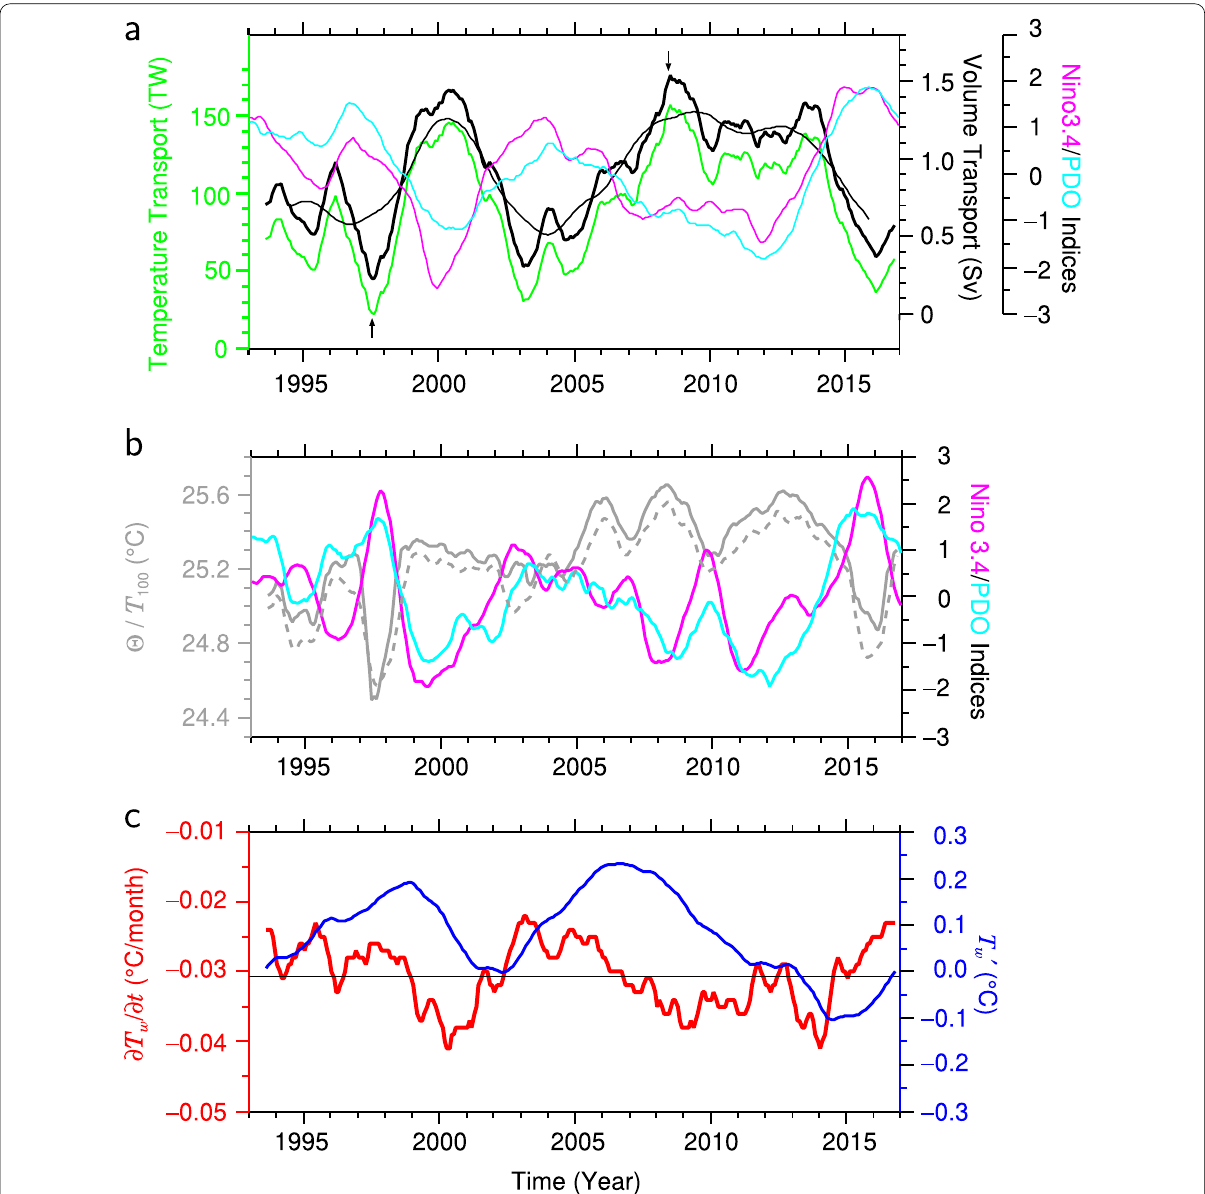
Fig. 14 a Volume transport V z (Sv, thick black line) and temperature transport F z (TW, green line) at 100 m depth in Region A shown by the solid square in Figs. 6, 7, 10, and 11. V z , Niño 3.4, and PDO indices smoothed by a 37-month running mean filter are shown by thin black, magenta, and cyan lines, respectively. Upward and downward arrows indicate July 1997 and July 2008, respectively. b Volume transport-weighted temperature (cid:31) ( ◦ C, gray solid line) and area-averaged temperature T 100 ( ◦ C, gray dashed line) at 100 m depth and Niño 3.4 (magenta line) and PDO (cyan line) indices. c Upper-ocean ( < 100 m depth) temperature tendency, ∂ T w /∂ t , averaged in Region A ( ◦ Cmonth − 1 , red line) and temperature variation, ◦ C , blue line) in the top 100 m layer. The horizontal black thin line indicates the mean value of the upper-ocean temperature tendency T ′ w , ( ( − 0.031 ◦ Cmonth − 1 ). The climate indices in panels a and b were normalized by the standard